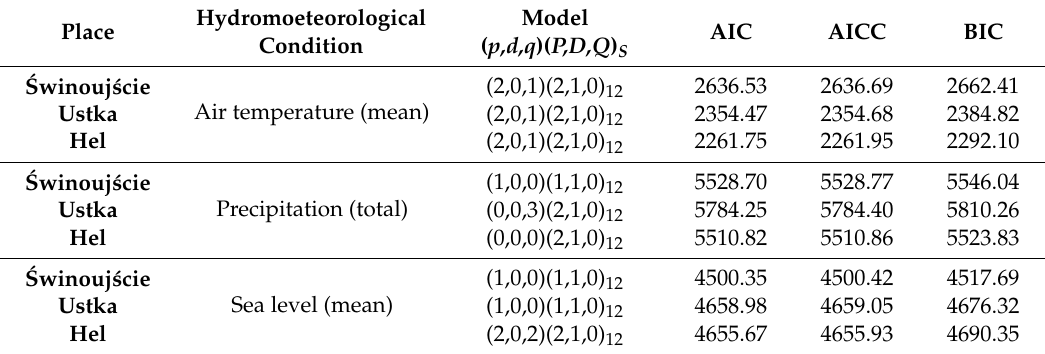
Table 1. Goodness-of-fit criteria (AIC, AICC, BIC) for ARIMA models. Place